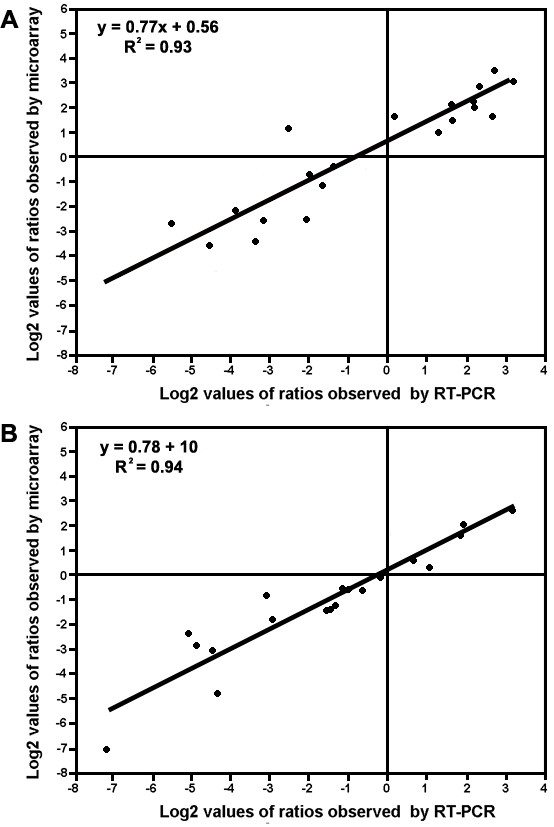
Comparison of gene expression ratios reported by the Affymetrix GeneChip® Vitis oligonucleotide microarray and by quantitative real-time RT-PCR. Data were from 19 probesets and three different tissues (pulp, skin and seed) from well-watered vines including comparisons from two probesets and two tissues (pulp and skin) between well-watered and water-deficit stressed vines. The microarray log2 (expression ratio) values (y-axis) are plotted against the log2 (expression ratio) obtained by quantitative real-time RT-PCR (x-axis). A) Comparisons between pulp and skin. B) Comparisons between pulp and seed. Linear regression analysis showed an overall coefficient of variation of 0.93 and 0.94, respectively (formula insets).